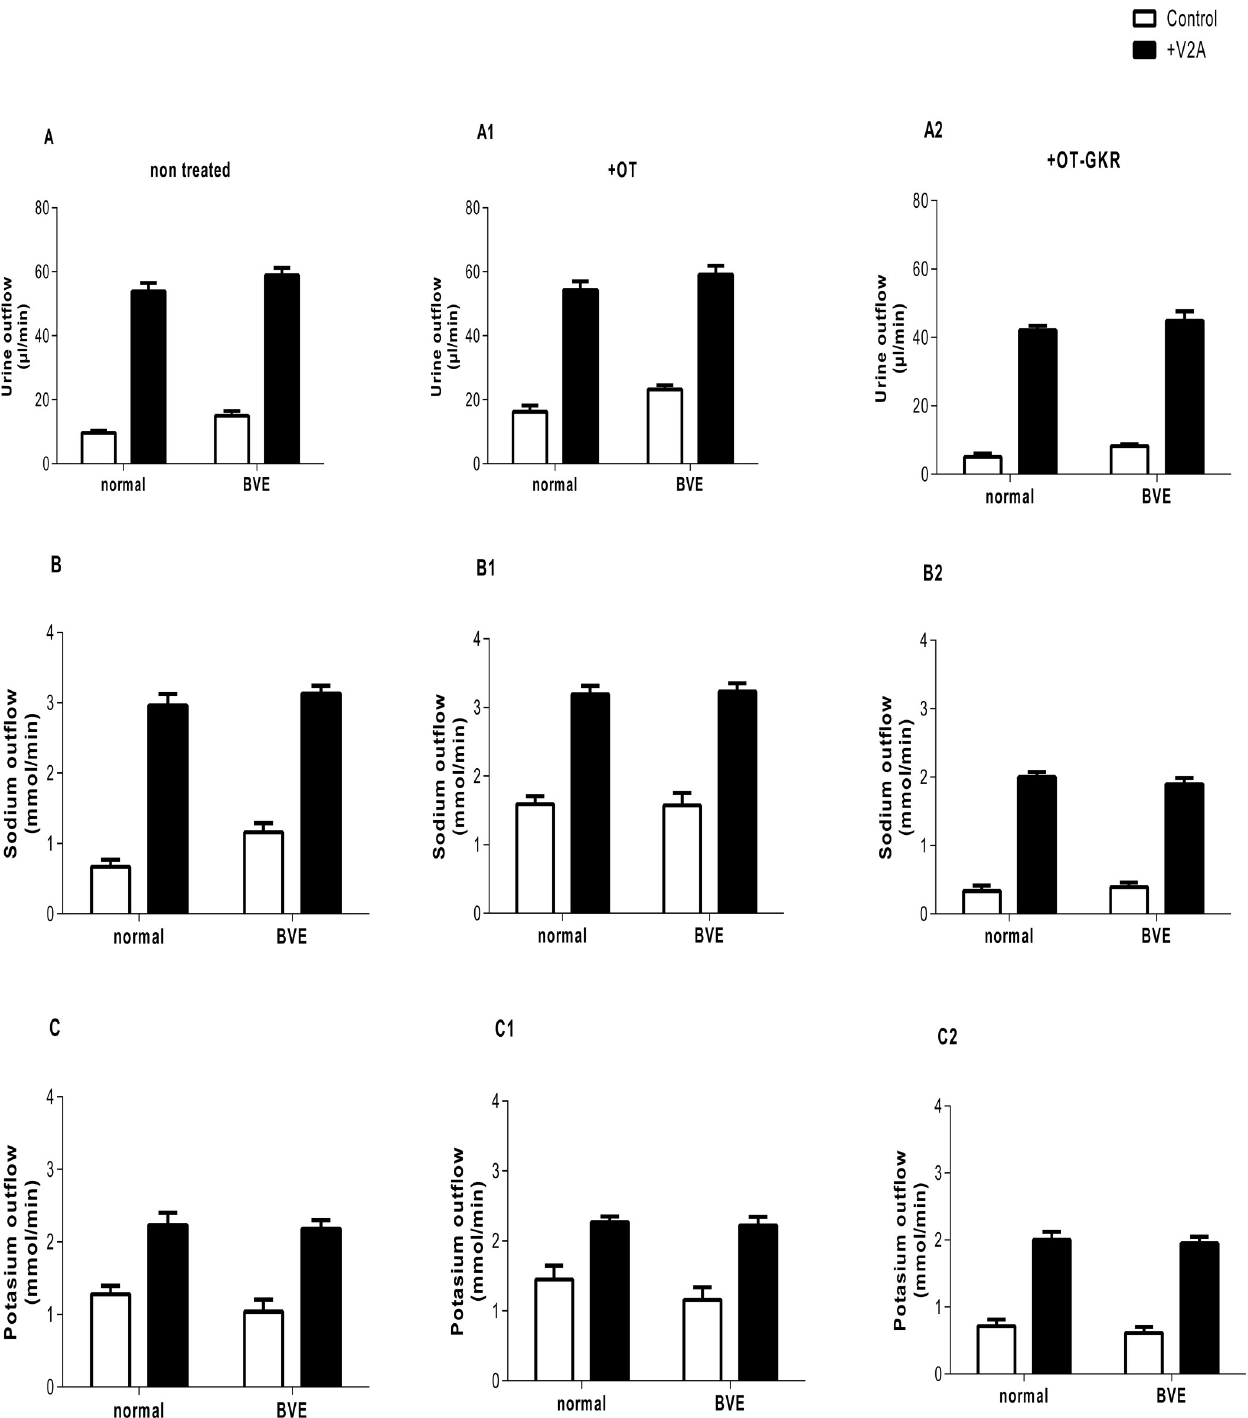
Fig 3. The effects of oxytocin (OT) and oxytocin extended form (OT-GKR) on diuresis, natriuresis and kaliuresis in the presence of a vasopressin receptor 2 antagonist (V2A). (A-A2) diuresis, (B-B2), natriuresis and (C-C2) kaliuresis. Measurement of urine and electrolyte outflow was performed following a normal volume injection (0.1 mL) and with blood volume expansion (5 mL, BVE). Statistical analysis was performed using a two-way ANOVA.